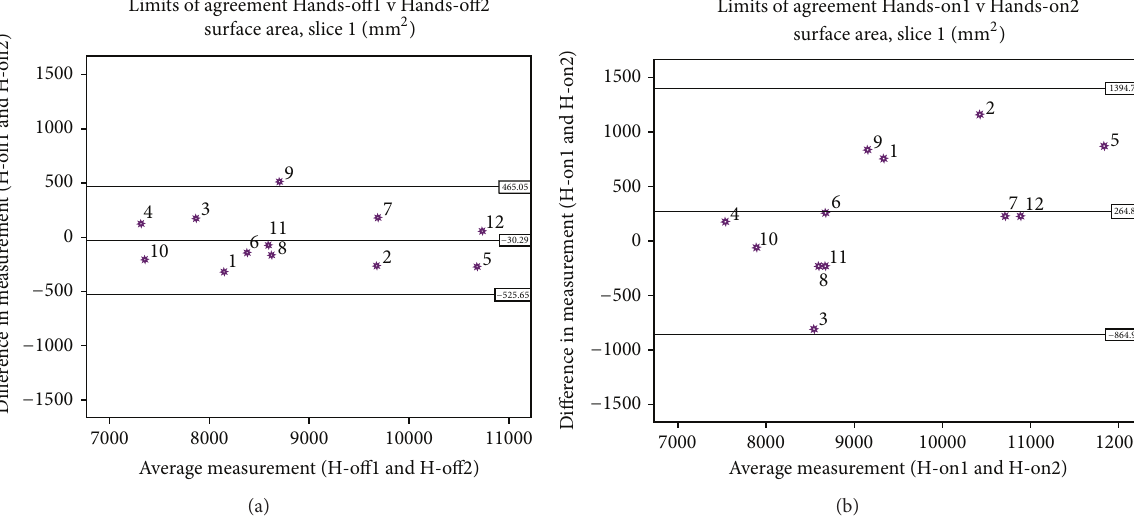
Figure 4: Bland and Altman plot for intracast CSSA of both Hands-off (a) and Hands-on (b) castings in slice